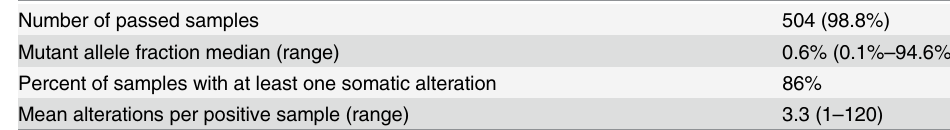
Table 4. Observational results from 510 patient multicenter research study utilizing the Guardant360 54-gene panel. Number of passed samples